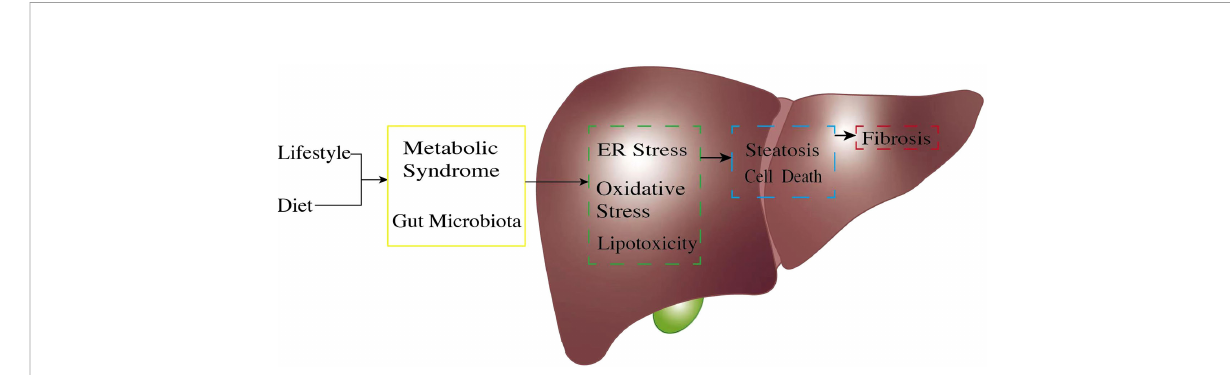
FIGURE 1 The pathogenic process of non-alcoholic fatty liver disease (NAFLD). The pathogenetic process of NAFLD always starts from unsatisfactory customs in daily life. An unhealthy lifestyle and poor diet, exceptionally high fructose, and a high-fat diet will trigger gut microbiota dysregulation. Unbalanced gut microbiota exposes liver cells to an endotoxic environment by producing short-chain fatty acids and secondary bile acids. At the same time, metabolic syndrome, through factors such as obesity and insulin resistance, causes excessive free fatty acid production because of unsatisfactory energy homeostasis. Once the body reaches its limit for lipid management, this will cause lipid accumulation in the liver cells; expose liver cells to high ER stress, oxidative stress, and lipotoxic condition (green box); and result in